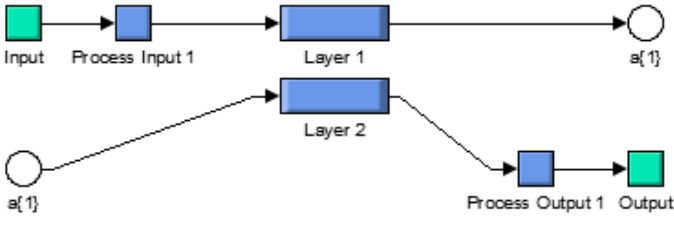
Figure 10. Structure of artificial neural network used in this study.